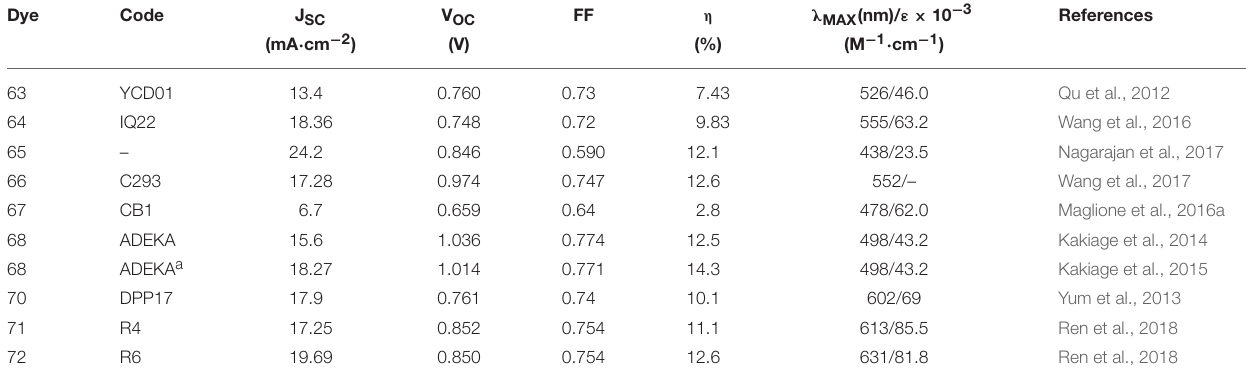
TABLE 4 | Photovoltaics parameters of DSSC sensitized with metal free sensitizers 62–71. Dye